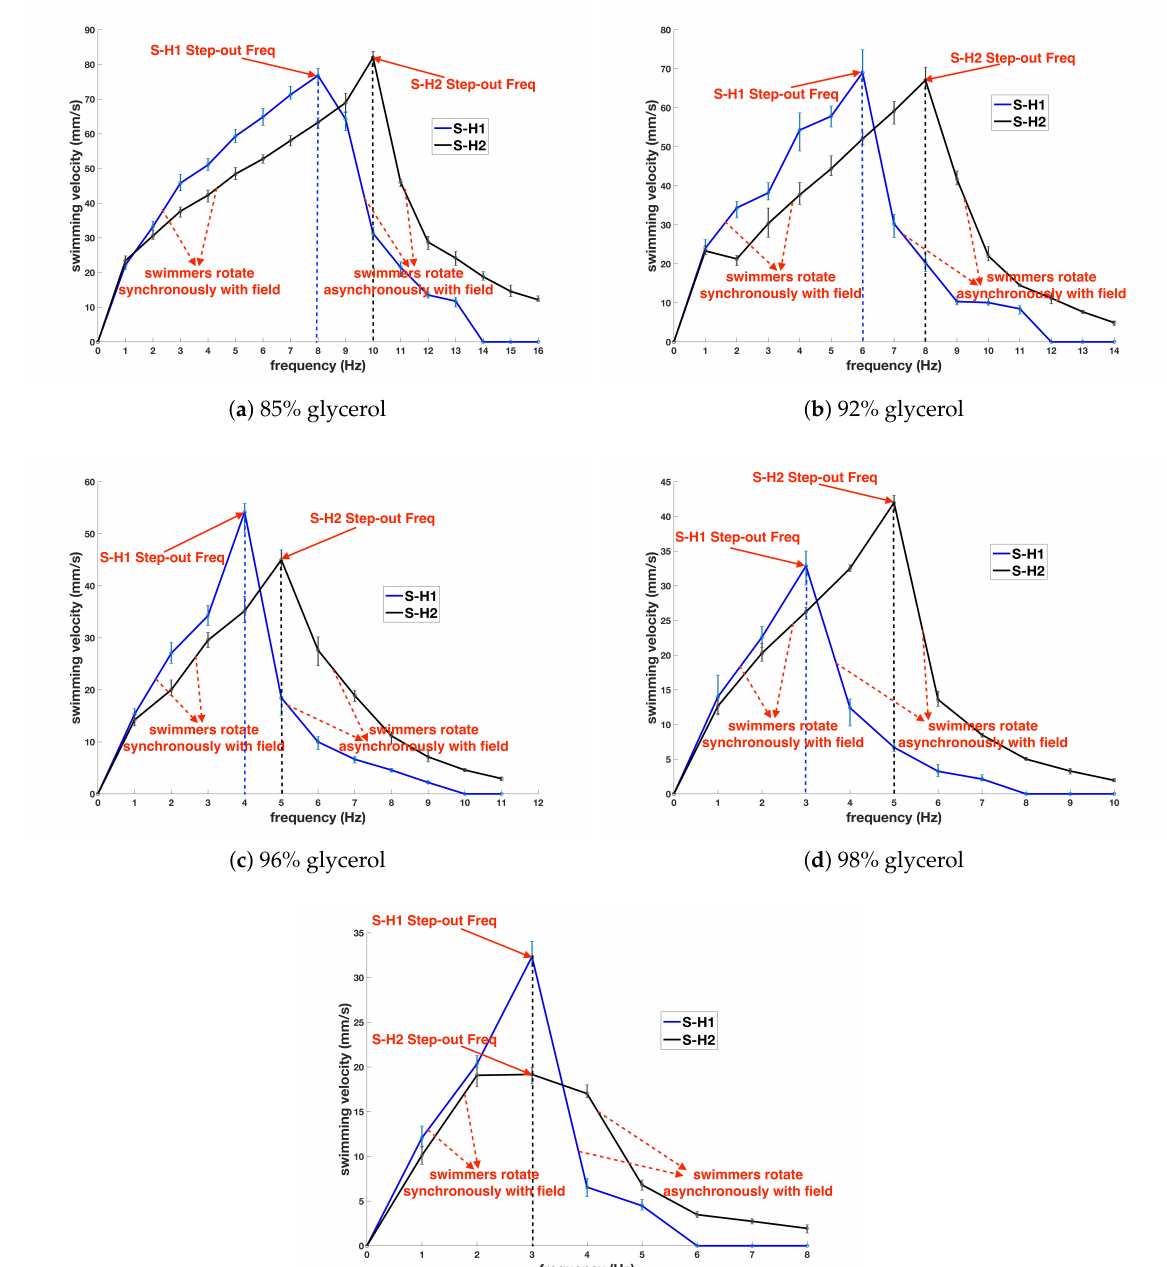
Figure 4. The propulsion velocity of S-H1 and S-H2 as a function of rotation frequency in different viscous